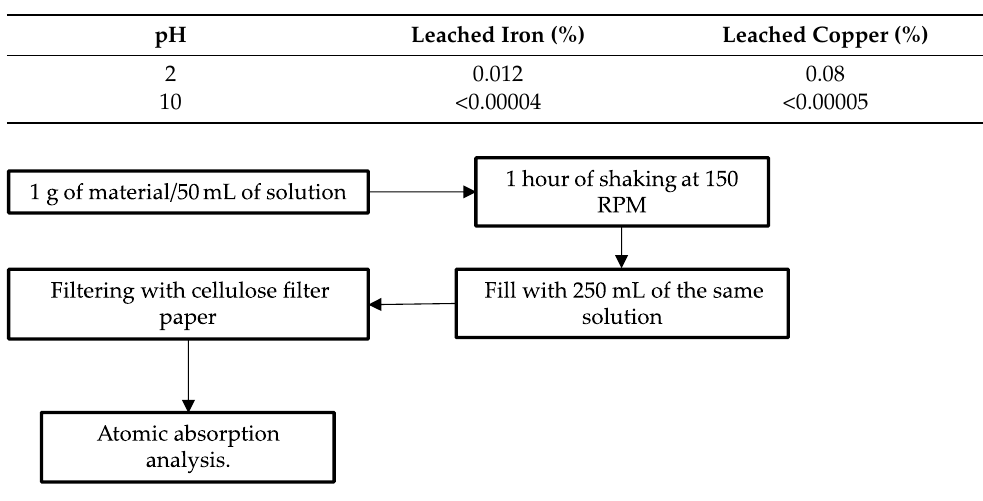
Table 3. Leaching test results.